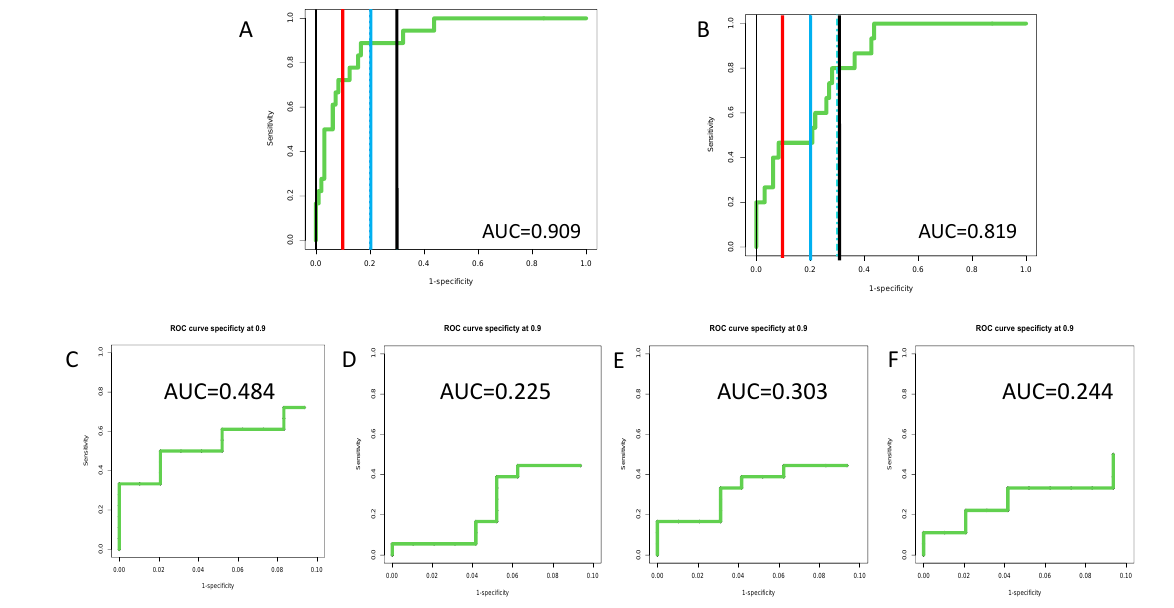
Figure 4. ( A ) Diagnostic algorithm dramatically improves detection of HCC. A diagnostic algorithm was developed using the combined UT, SLU, and UCSD cohorts (training set, n = 426). Panels ( A , B ) show external validation of the diagnostic algorithm in patients either at 1–6 prior to HCC detection or 7+ months prior to HCC detection. In Panels ( A , B ), red lines mark 90% specificity, blue lines mark 80% specificity and black lines mark 70% specificity. Panels ( C – F ) show the 90-ROC of the diagnostic algorithm ( C ), PEG-IgG ( D ), AFP ( E ) or fucosylated kininogen ( F ) in the 1 – 6-month cohort. ROC curve specificity above 0.9